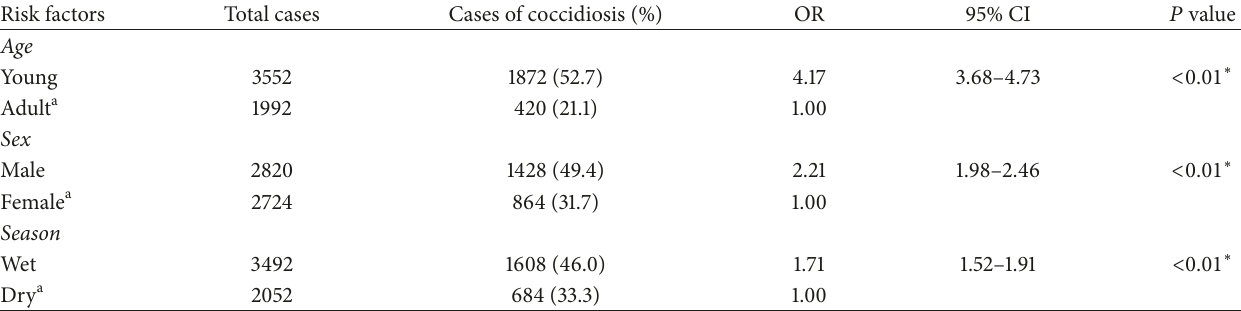
Table 3: Risk factors associated with avian coccidiosis in Osun State, Nigeria (2006–2015).